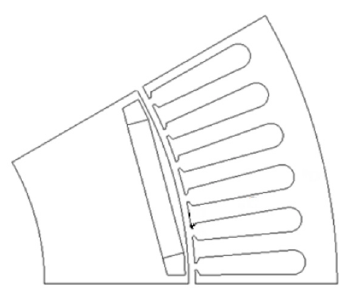
/ 12 2D model of an outer rotor space vector pulse width modulation Figure 1. 1/12 2D model of an outer rotor space vector pulse width modulation (PMSM). Figure 1. 1